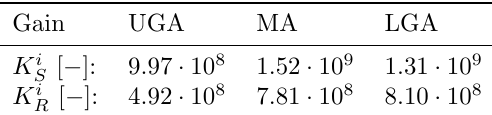
Table 5: Transmission line loss